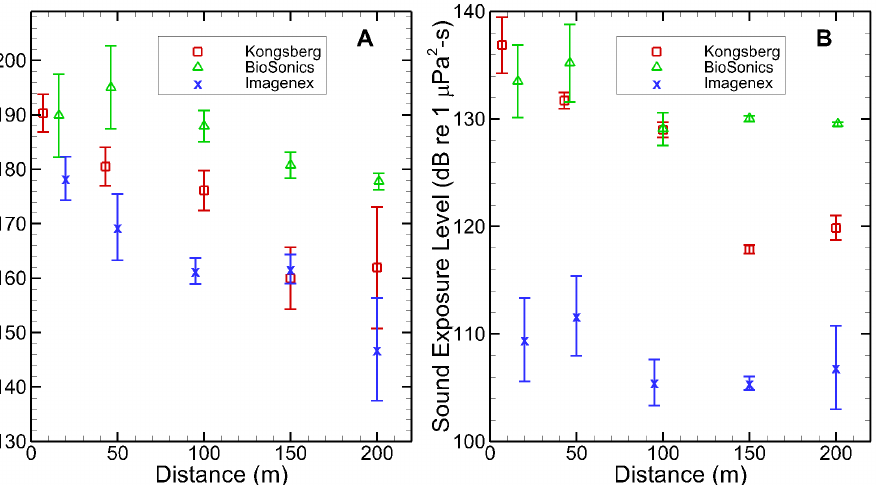
Figure 3. Sound pressure level and sound exposure level for three sonar units. A . Root-mean-square sound pressure level measurements; B . M mf weighted sound exposure level